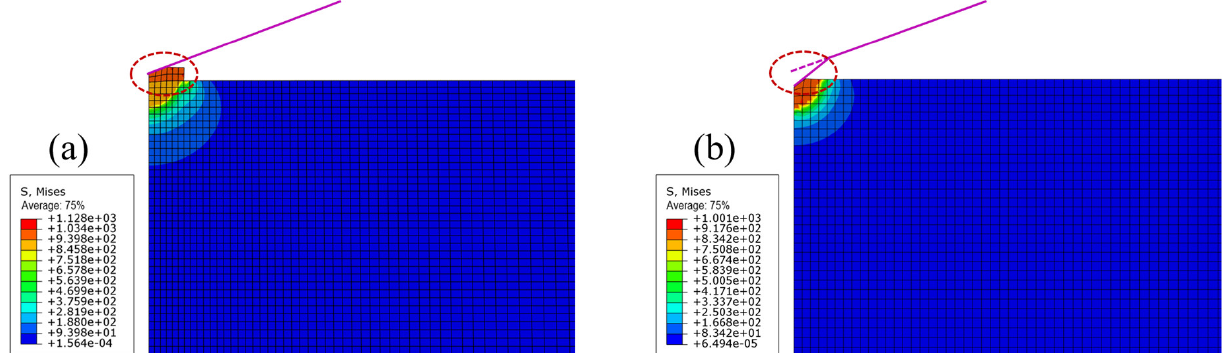
Figure 15. Stress distribution of simulation process: ( a ) tip impurity; ( b ) tip sharpness.